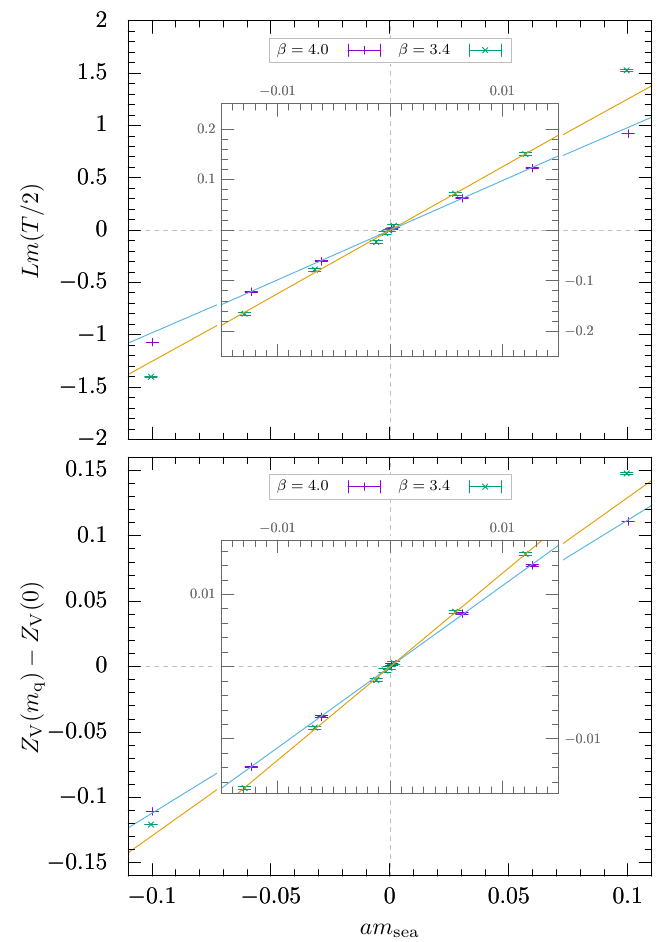
Figure 1. Sea quark mass-dependence ( m q = m sea ) of the current quark mass Lm and renor- malization factor Z V with typical interpolating functions at (cid:12) = 4 : 0 ; 3 : 4. The inner graph is a magni(cid:12)cation of data entering the straight line (cid:12)t close to the chiral limit ( am q < 0 : 014), while j j the outer graph visualises the deviation from linear behaviour far away from the chiral limit. All data points are independent from each other and taken from table 2. The quality of (cid:12)t tends